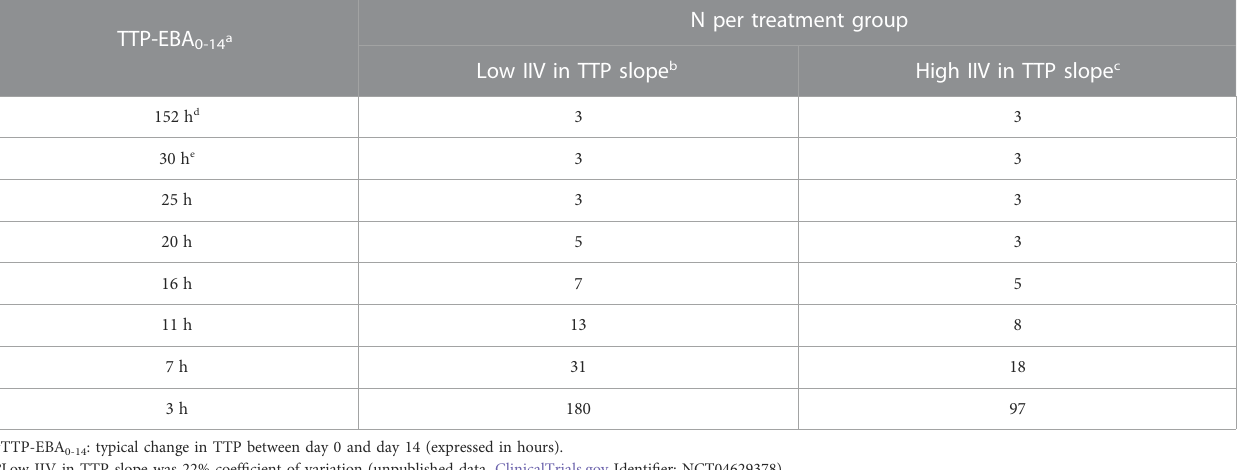
TABLE 1 Sample size per group needed to detect early bactericidal activity (EBA) with 80% power at a 5% signi fi cance level for various changes in time-to- positivity between days 0 and 14 (TTP-EBA 0-14 ) and inter-individual variability (IIV) in TTP slope. Power calculations were performed using a mono-exponential model with various TTP-EBA 0-14 values for both low and high IIV in TTP slope. For each scenario, power calculations included a minimum of 3 patients.